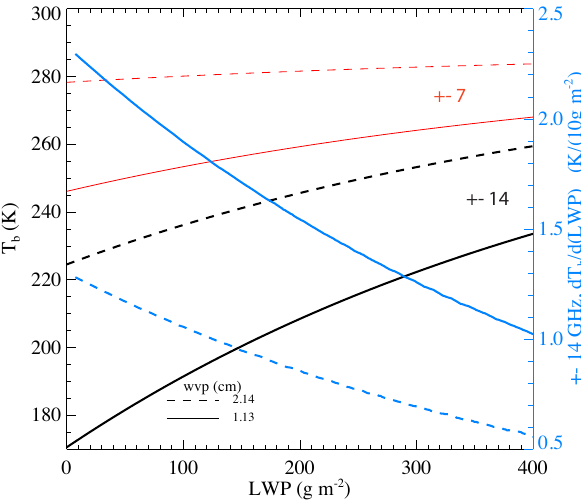
Fig. 3. Brightness temperatures for the outer wing channels ( ± 14 and ± 7GHz; black and red lines respectively) as a function of liq- uid water path at 150m altitude for the 10th and 90th percentile (dashed and solid lines) water vapor profiles represented in Fig. 2. T b sensitivity to LWP for the ± 14GHz channel is shown in blue, with values indicated on right-hand